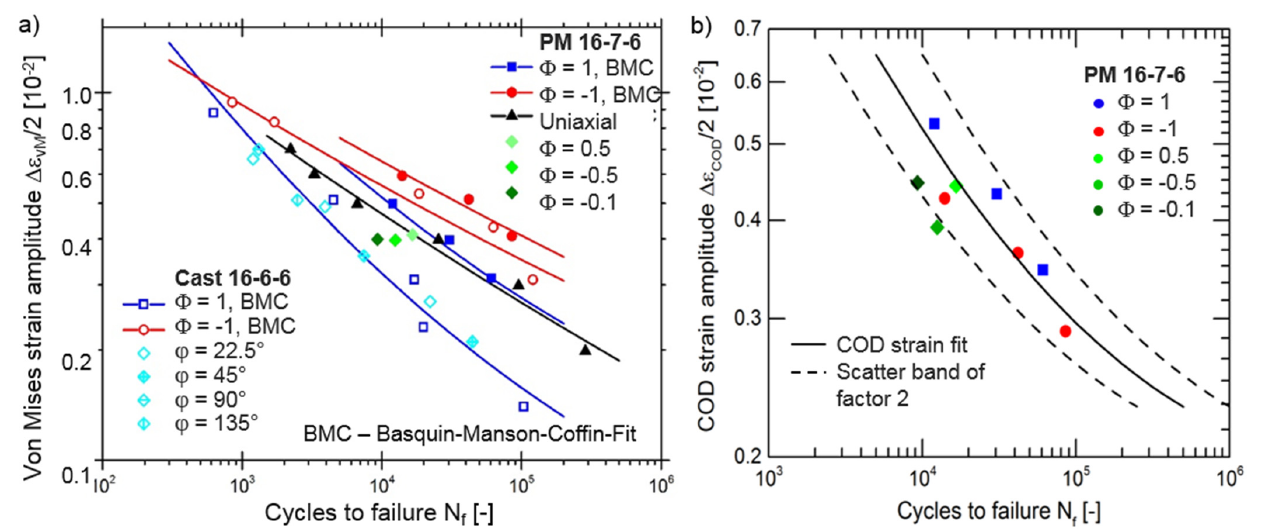
Figure 5: Fatigue lives N f of PM steel 16-7-6 and cast steel 16-6-6 [9] under uniaxial and biaxial cyclic straining (strain ratio  , phase shift  ) vs. a) von Mises equivalent strain amplitude Δ  vM /2 and b) COD strain amplitude Δ  COD /2 according to [3].